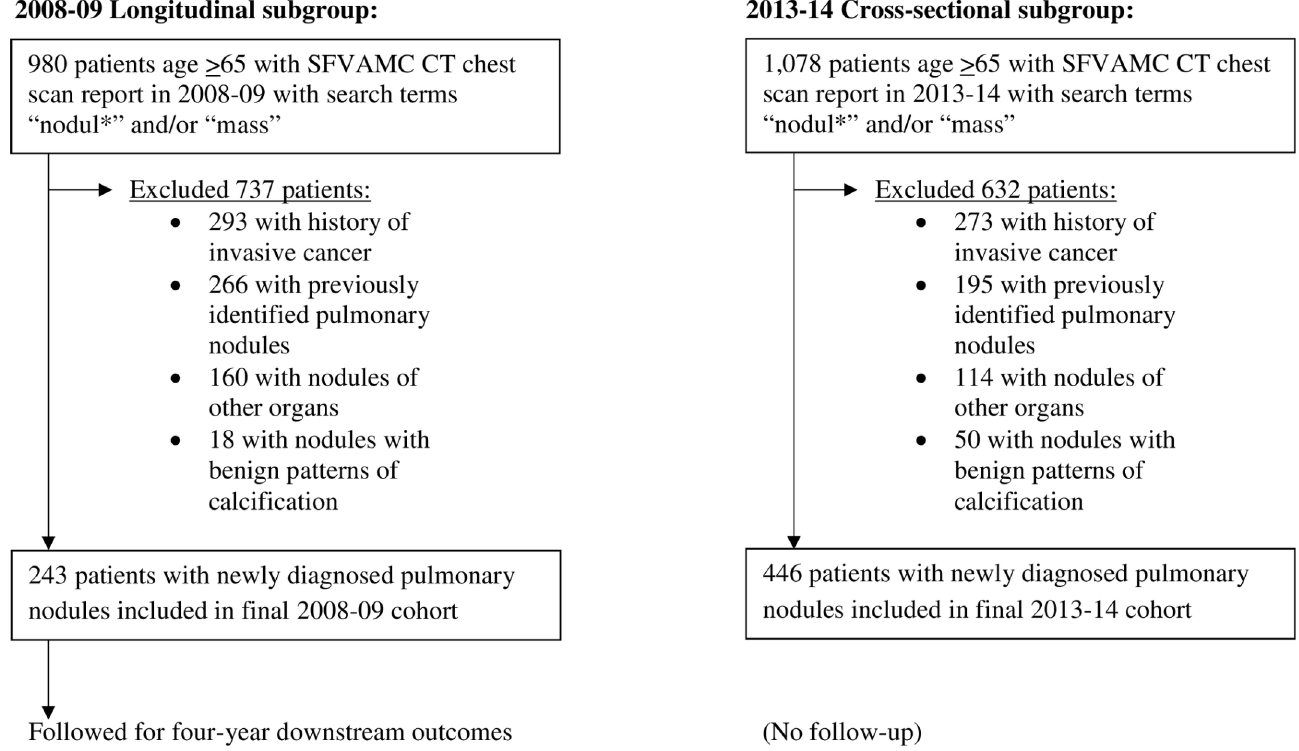
Fig 1. Exclusions used to define the final cohort of older veterans with a newly diagnosed pulmonary nodule at the SFVAMC in 2008–09 and 2013–14.